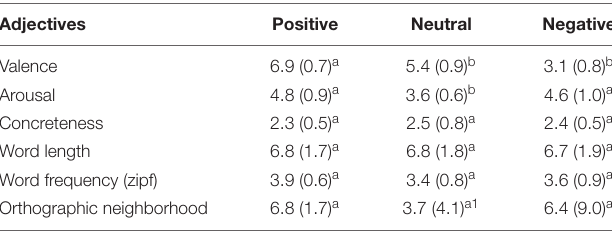
TABLE 4 | Means for the word attributes for the set of English